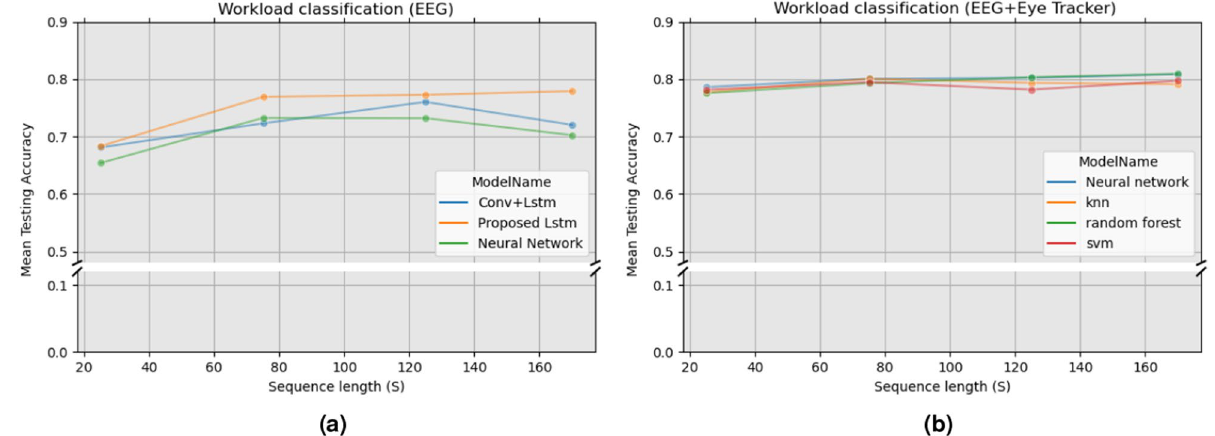
Figure 1. ( a ) Correlation between accuracy and sequence length in dataset 1. The best performing model is our proposed recurrent architecture based on LSTM cells. ( b ) Correlation between accuracy and sequence length for dataset 2. The best performing was a feed-forward neural network.